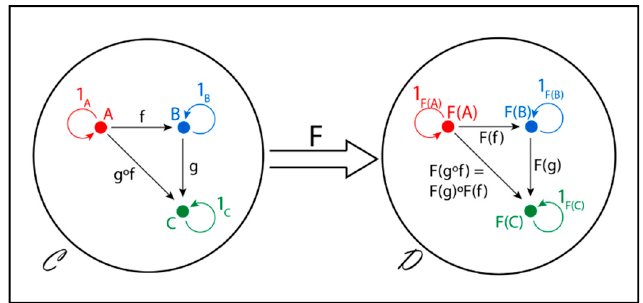
Figure 6. Object to object mapping example in a GTPL (graph theoretic programming language).